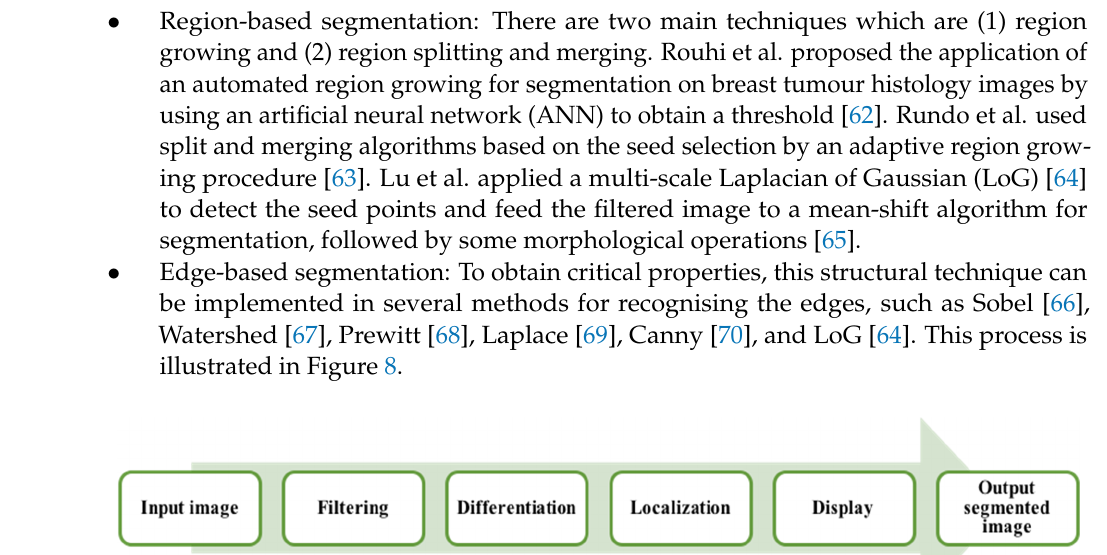
Figure 7. General view of segmentation approaches and techniques.